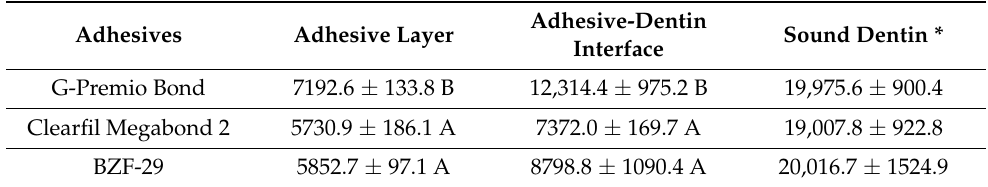
Table 3. Mean elastic modulus ± standard deviation measured in MPa for different locations ( n = 9 indentations/location/group).